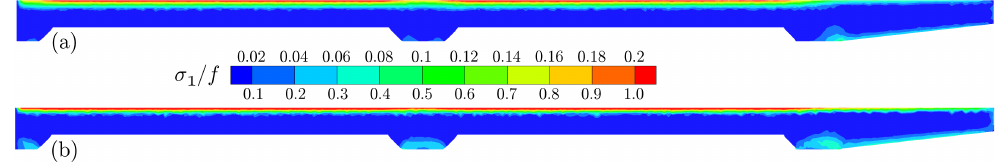
Figure 22. Spatial maps of cracking potential at t = 11.42days (8pm on day 11) for the case where the curing sheets were removed at t = 9days: ( a ) thermal stress component; and ( b ) total stress.